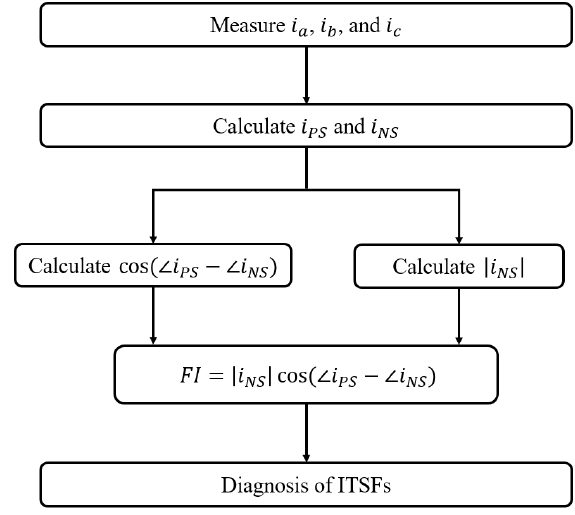
Figure 3. Flow chart for diagnosis of ITSFs in a PMSM.